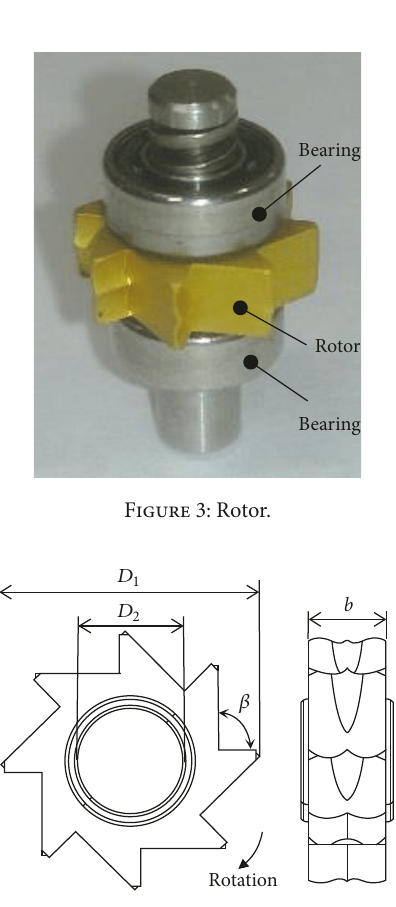
Figure 4: Schematic of